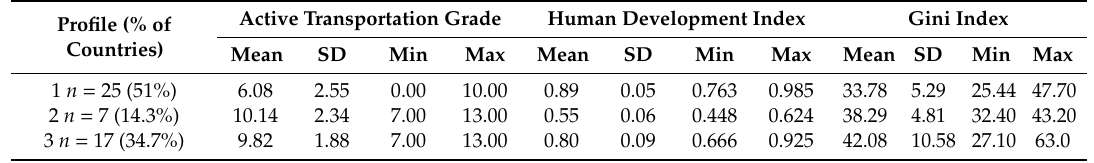
Table 4. Descriptive statistics of the latent variables by country profile.